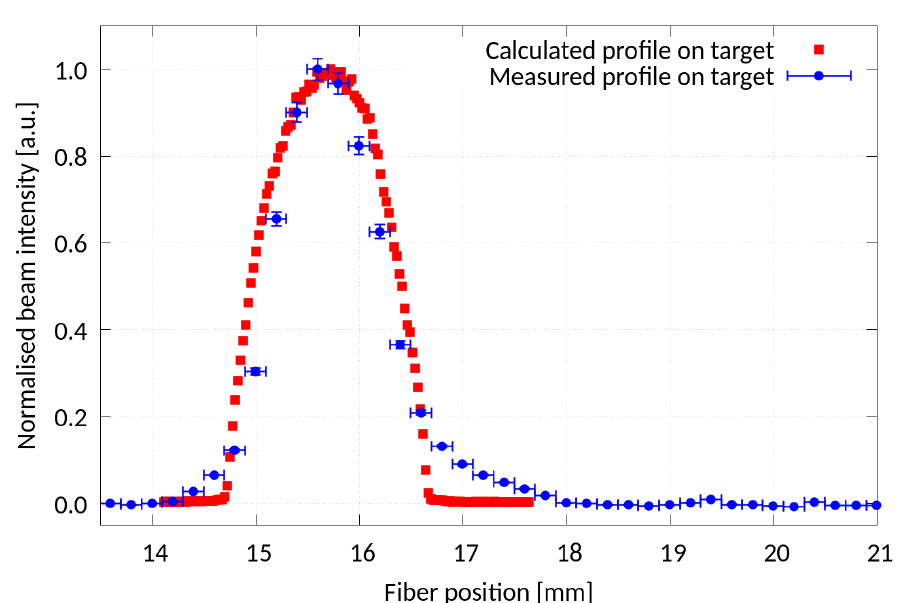
Figure 6. Beam profiles at the target position measured by the UniBEaM detector (blue) and calcu- lated